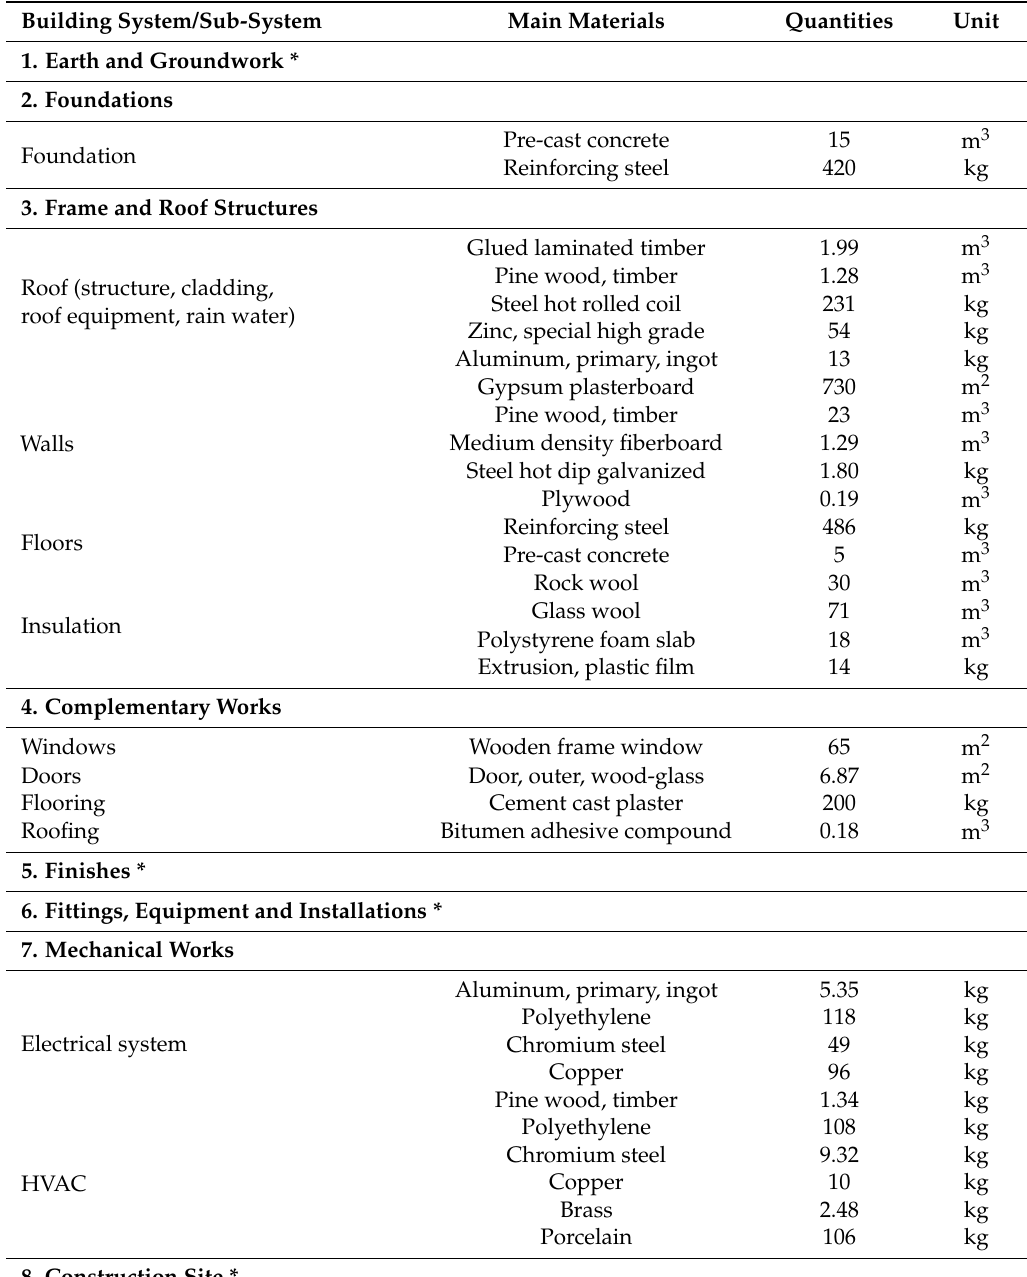
Table 2. The eight main building systems of KÄPYLÄ and the main materials in each